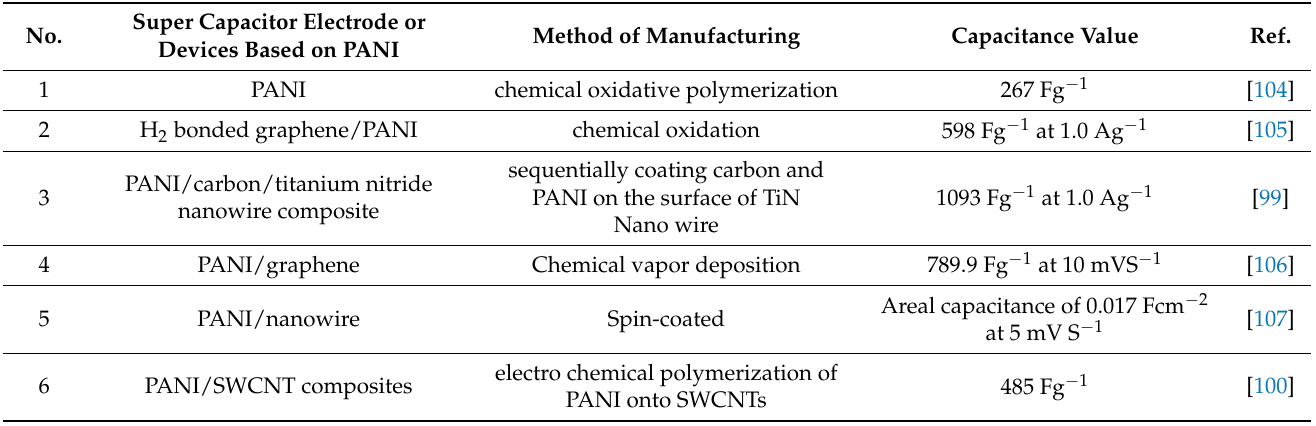
Table 3. Supper capacitors devices or electrodes based on